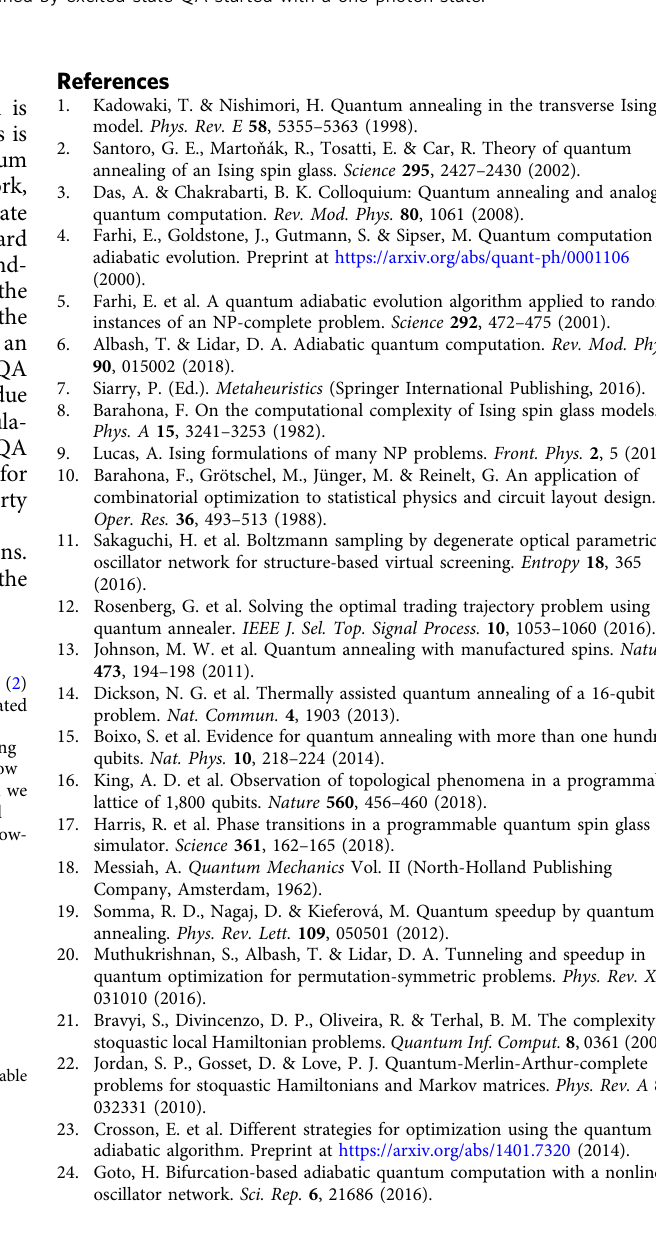
Fig. 6 Success probabilities of excited-state quantum annealing for the ten worst instances of ground-state quantum annealing. The ten instances are characterized in Table 1 and Fig. 3 together with Supplementary Figs. 2 – 10. Each bar represents the success probability for each of the ten instances without ( κ = 0) and with ( κ = 0.005 K ) dissipation, where κ is a fi eld decay rate for each Kerr-nonlinear parametric oscillator. The instances are ordered in descending order with respect to the failure probability of ground-state quantum annealing (QA), as in Table 1, from left. a Results obtained by the proposed excited-state QA started with vacuum states. b Results obtained by excited-state QA started with a one-photon